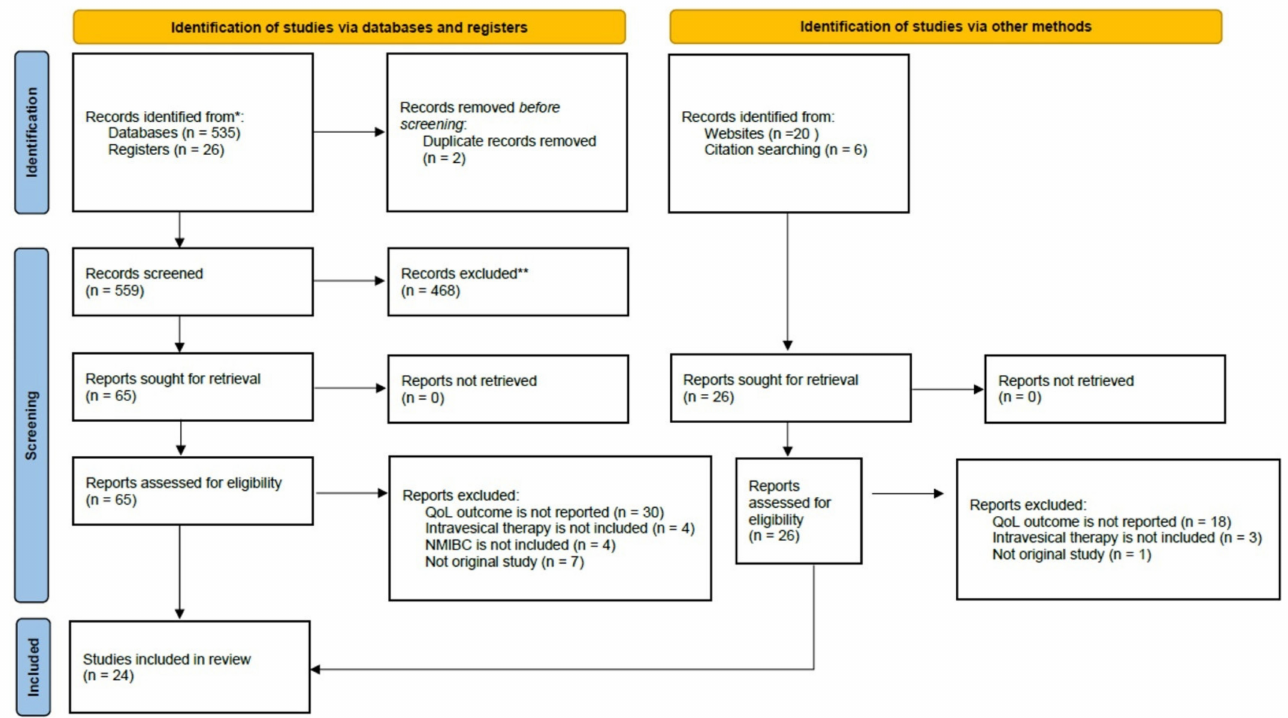
Figure 1. The process of literature screening and selection presented using the PRISMA 2020 flow diagram. * PubMed and the Cochrane library database; ** Studies did not involve NMIBC patients, did not include quality-of-life as outcome measures, and non-English